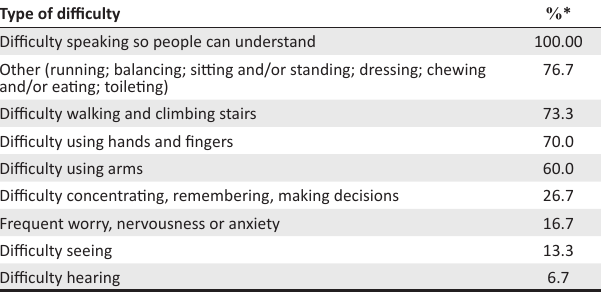
TABLE 2: Type of difficulty experienced by participants ( N = 30). Type of difficulty